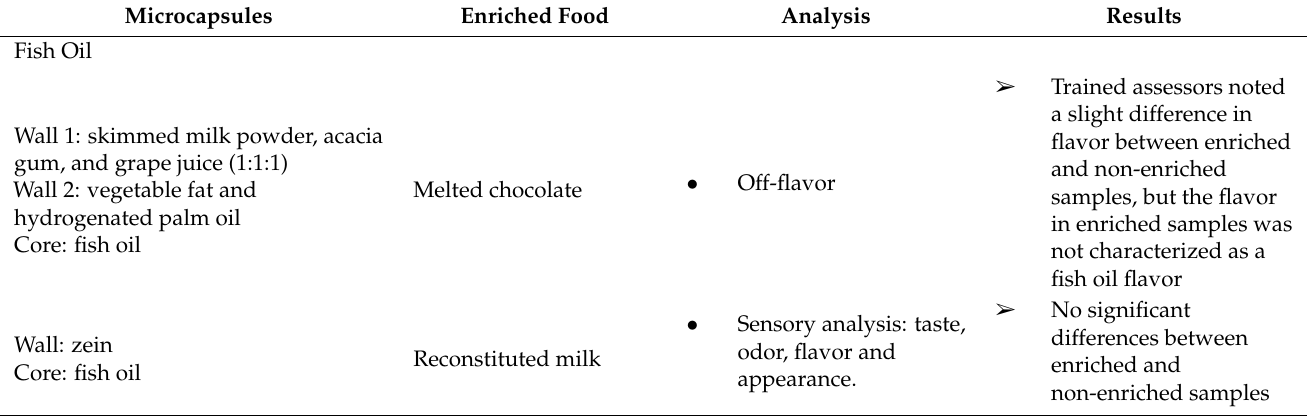
Table 4. Enrichment of foods with fish oil and natural antioxidant microcapsules: main details. Microcapsules Enriched Food Analysis Results Fish